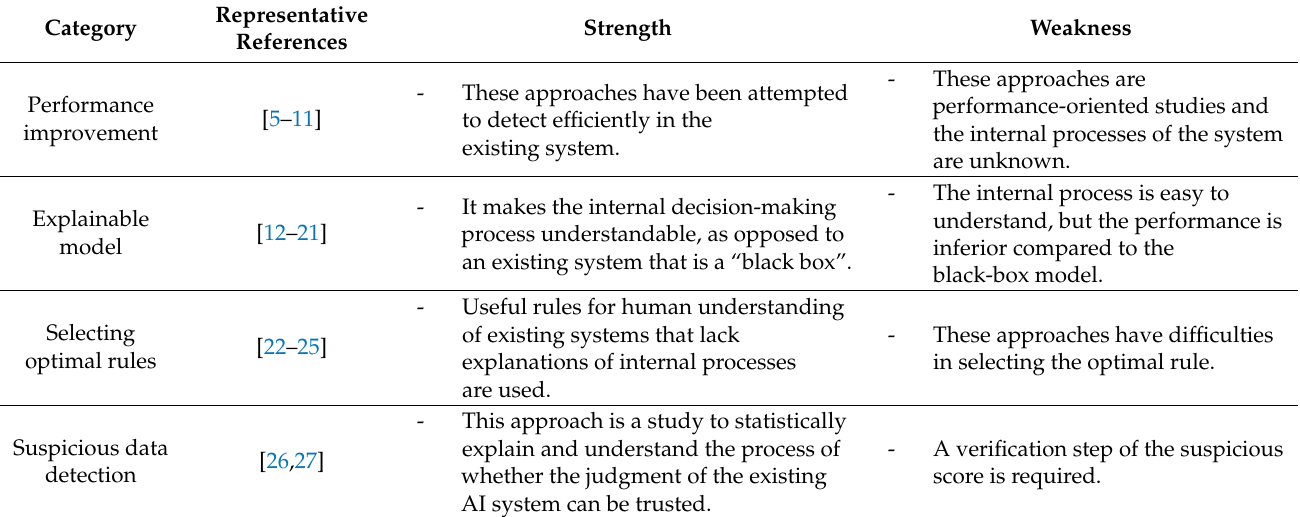
Table 1. Summary of existing